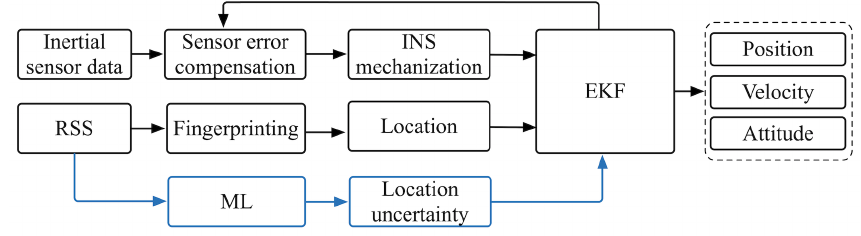
Figure 1. Algorithm flow